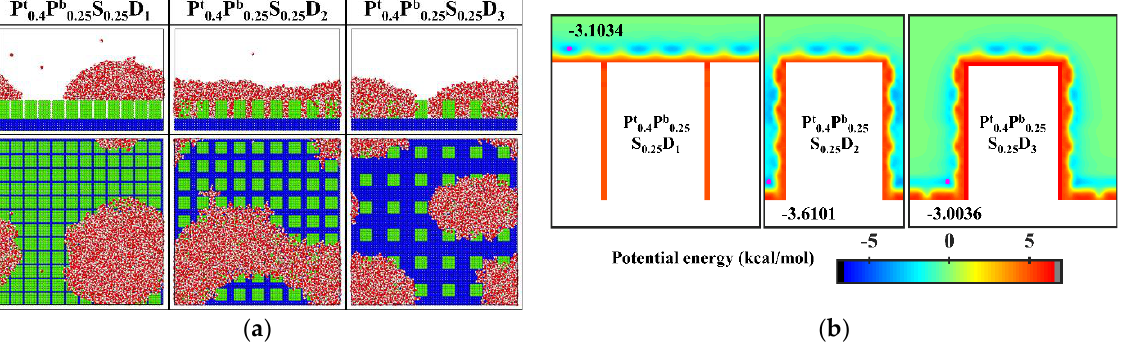
Figure 12. ( a ) The snapshot of the condensate formed on the surfaces P t 0.4 P b 0.25 S 0.25 D i at the end of the simulation ( b ) Equipotential curves of potential energy between water molecule and the nanopillar surfaces (P t 0.4 P b 0.25 S 0.25 D i ). The minimum values of the potential energy are given in the figure and their positions are marked with a pink